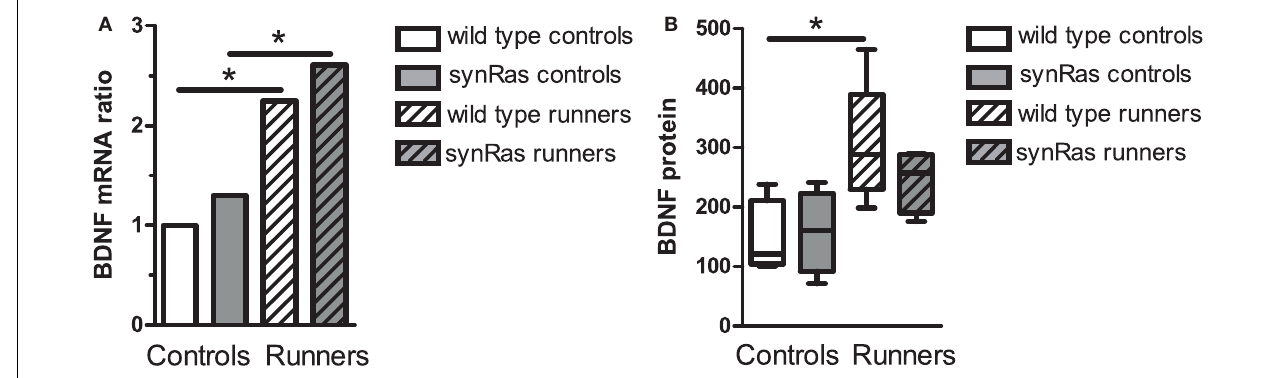
FIGURE 3 | Effects of physical activity on BDNF mRNA expression in wild type controls ( n = 6), synRas controls ( n = 5), wild type runners ( n = 5), synRas runners ( n = 5) (A) and protein expression (B) in wild type controls ( n = 4), synRas controls ( n = 4), wild type runners ( n = 5), synRas runners ( n =